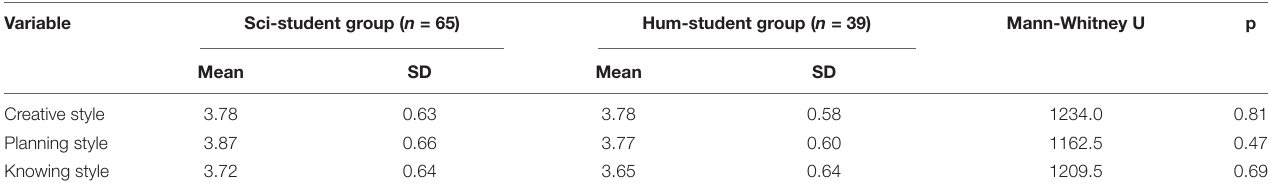
TABLE 3 | Analysis of the between-group differences in cognitive